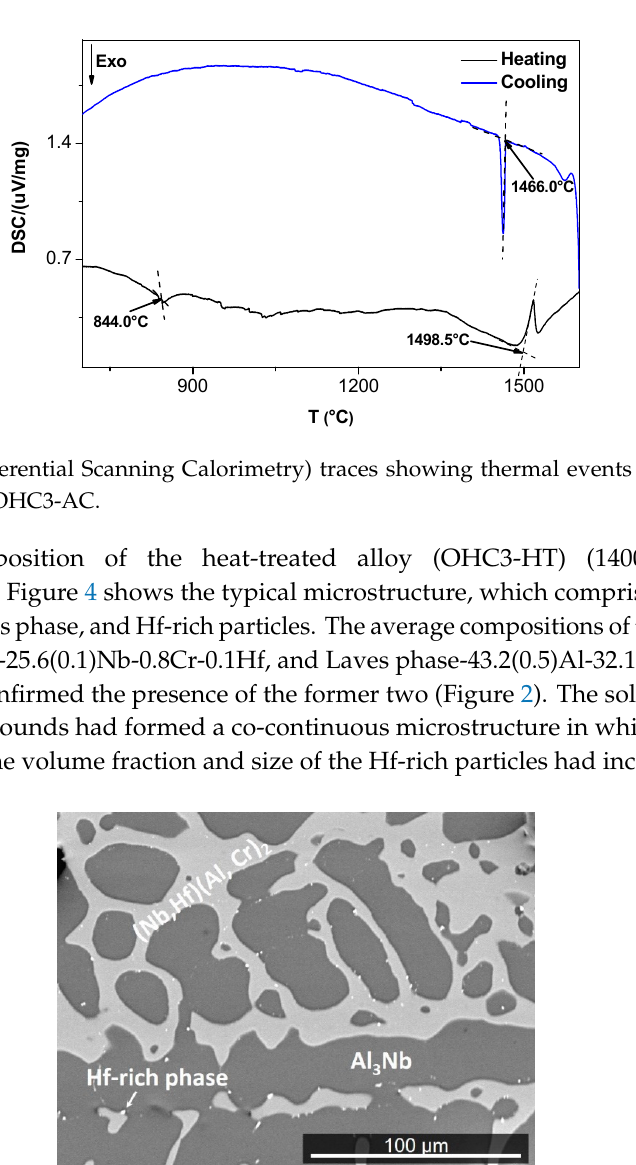
Figure 4. BSE image of the microstructure of OHC3-HT, X640.